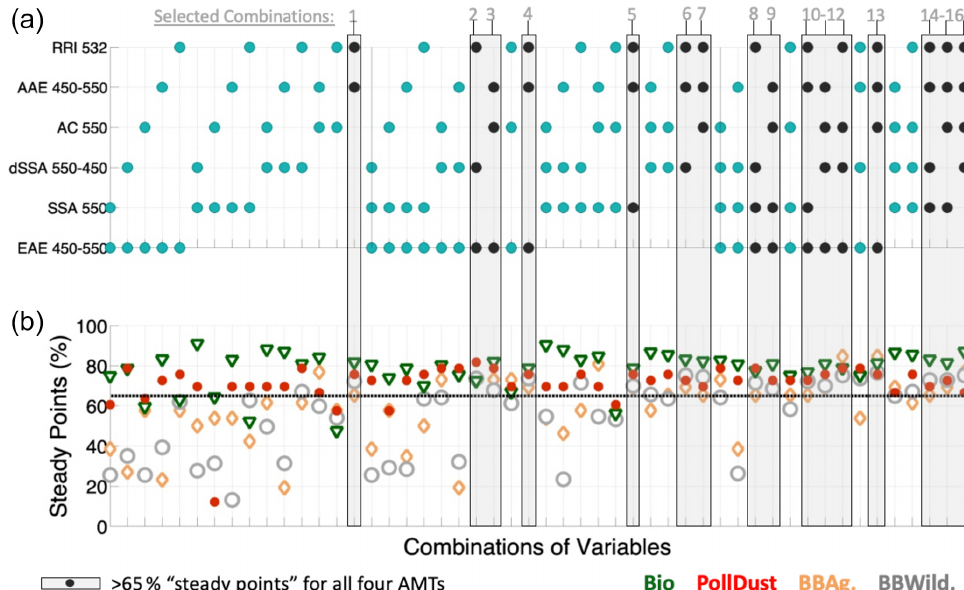
Figure 6. Percentage of steady points (i.e., fraction of cases of a given type that are correctly identified) in panel (b) when using different combinations of aerosol optical parameters in panel (a) for each PS-AMT. Grey boxes and black points depict combinations of optical parameters showing > 65% steady points for PS-AMTs BBAg., BBWild., Bio. and PollDust. RRI: real refractive index; AAE: absorption Ångström exponent; AC: absorption coefficient; dSSA: difference in single scattering albedo; SSA: single scattering albedo; EAE: extinction Ångström